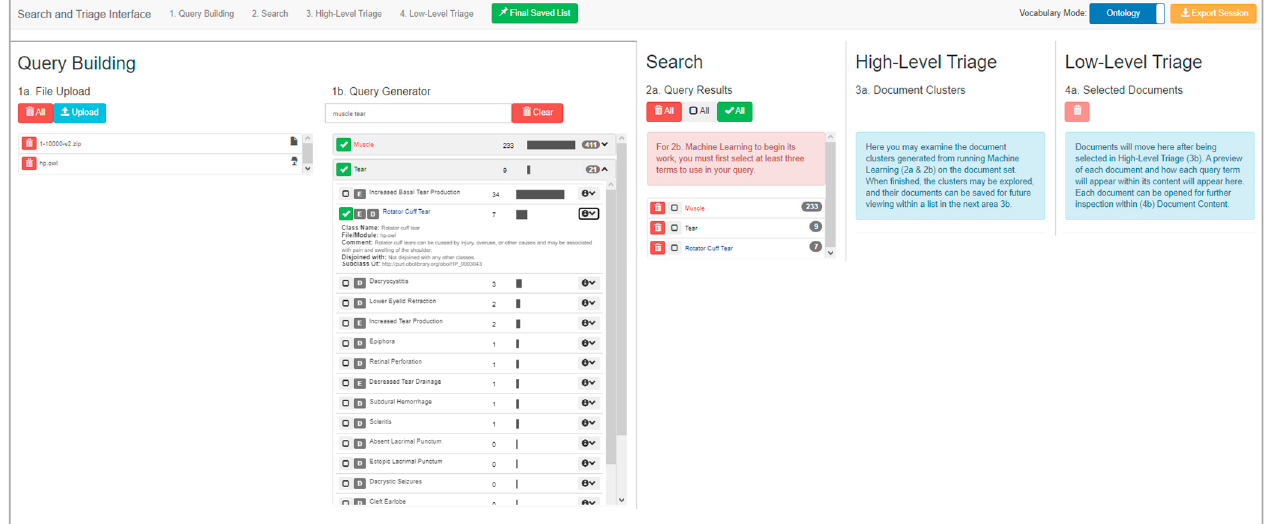
Figure 6. An overview of Query Building subview within VisualQUEST.